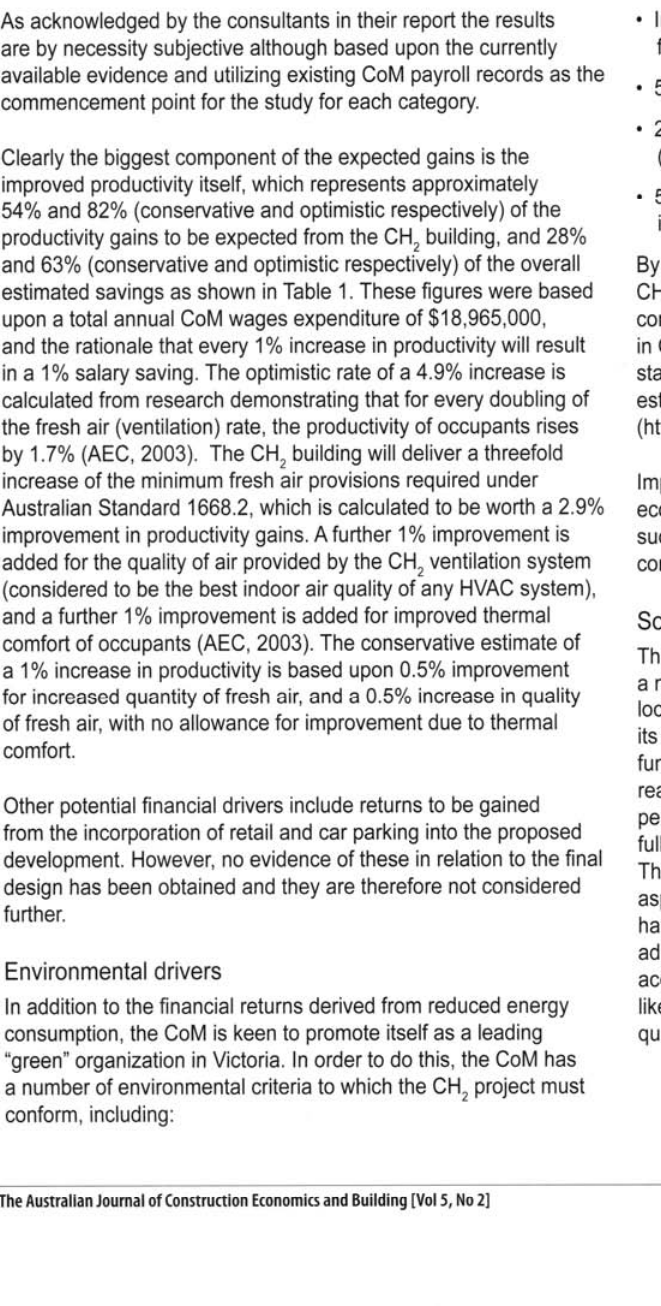
Table 5: Summary of Potential Productivity Gains at CH